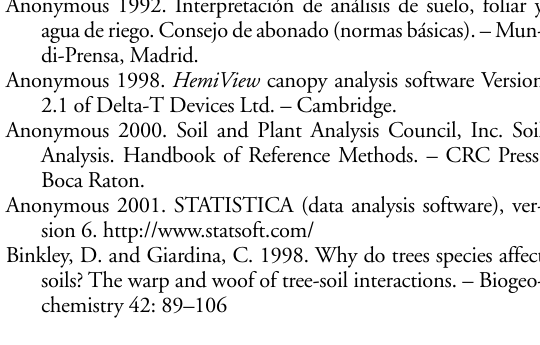
Table 4. Comparison of litter accumulation and soil properties between the end quartiles of the studied light-availability gradients. For each variable, the value of Mean ± Standard Deviation and of the ratio between means of end quartiles (Q